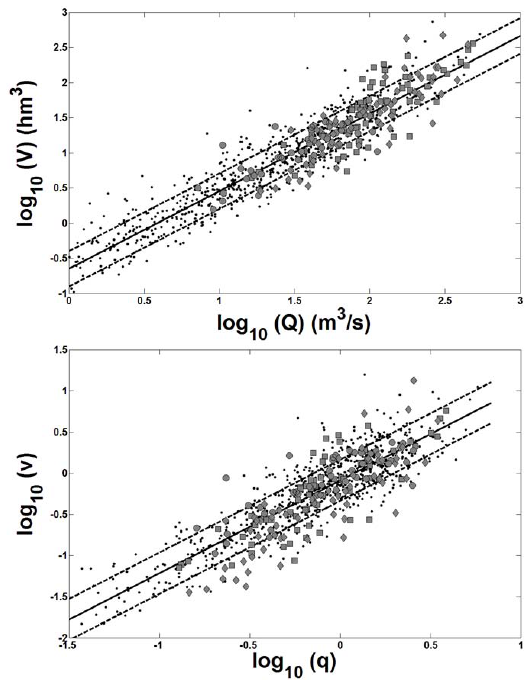
Fig. 2. Relationship between hydrograph volumes and peak flows. Solid lines are the regression equations and dotted lines show the confidence intervals for a confidence level of 33%. Solid points are the Q – V pairs in the whole region, squares are the pairs in the 93001 station, circles in the 93033 station and diamonds in the 93087 station. (a) Observed volumes ( V ) against observed peak flows ( Q) . (b) Standardized volumes ( v) against standardized peak flows ( q)